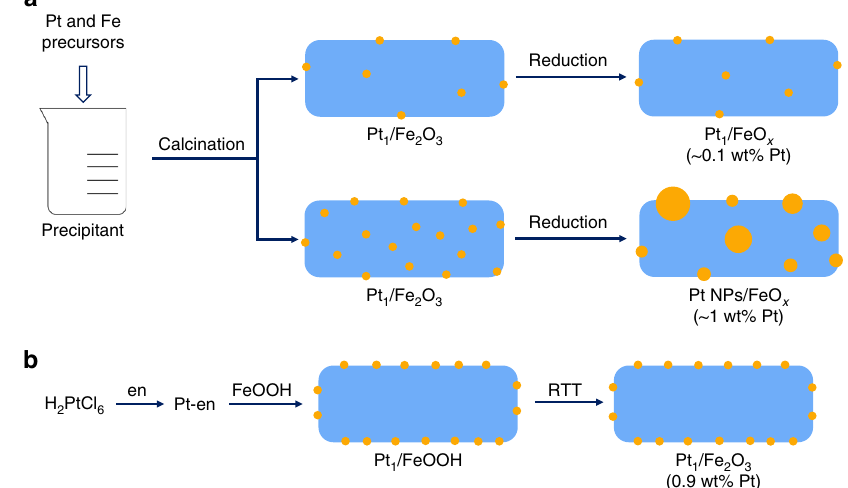
Fig. 1 Schematic illustration of different synthesis methods for Pt 1 /Fe 2 O 3 catalysts. a Co-precipitation (CP) method, showing the possible burying of a portion of Pt single atoms inside the Fe 2 O 3 support and the aggregation of single atoms during post-activation (reduction) process in the case of relatively high Pt loadings. b en-M-RTT method, showing the relatively high density of Pt single atoms predominantly located on the Fe 2 O 3 surface